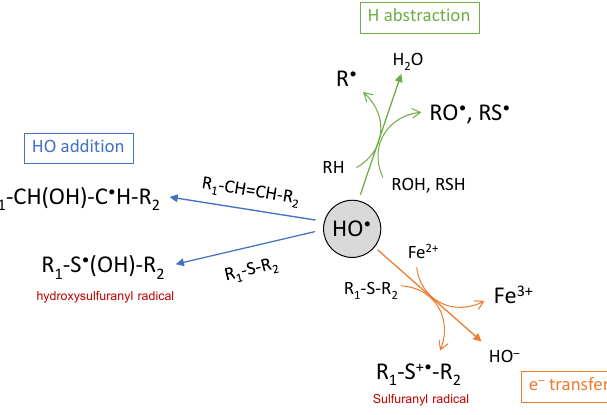
Figure 3. The chemical reactions of the hydroxyl radical.